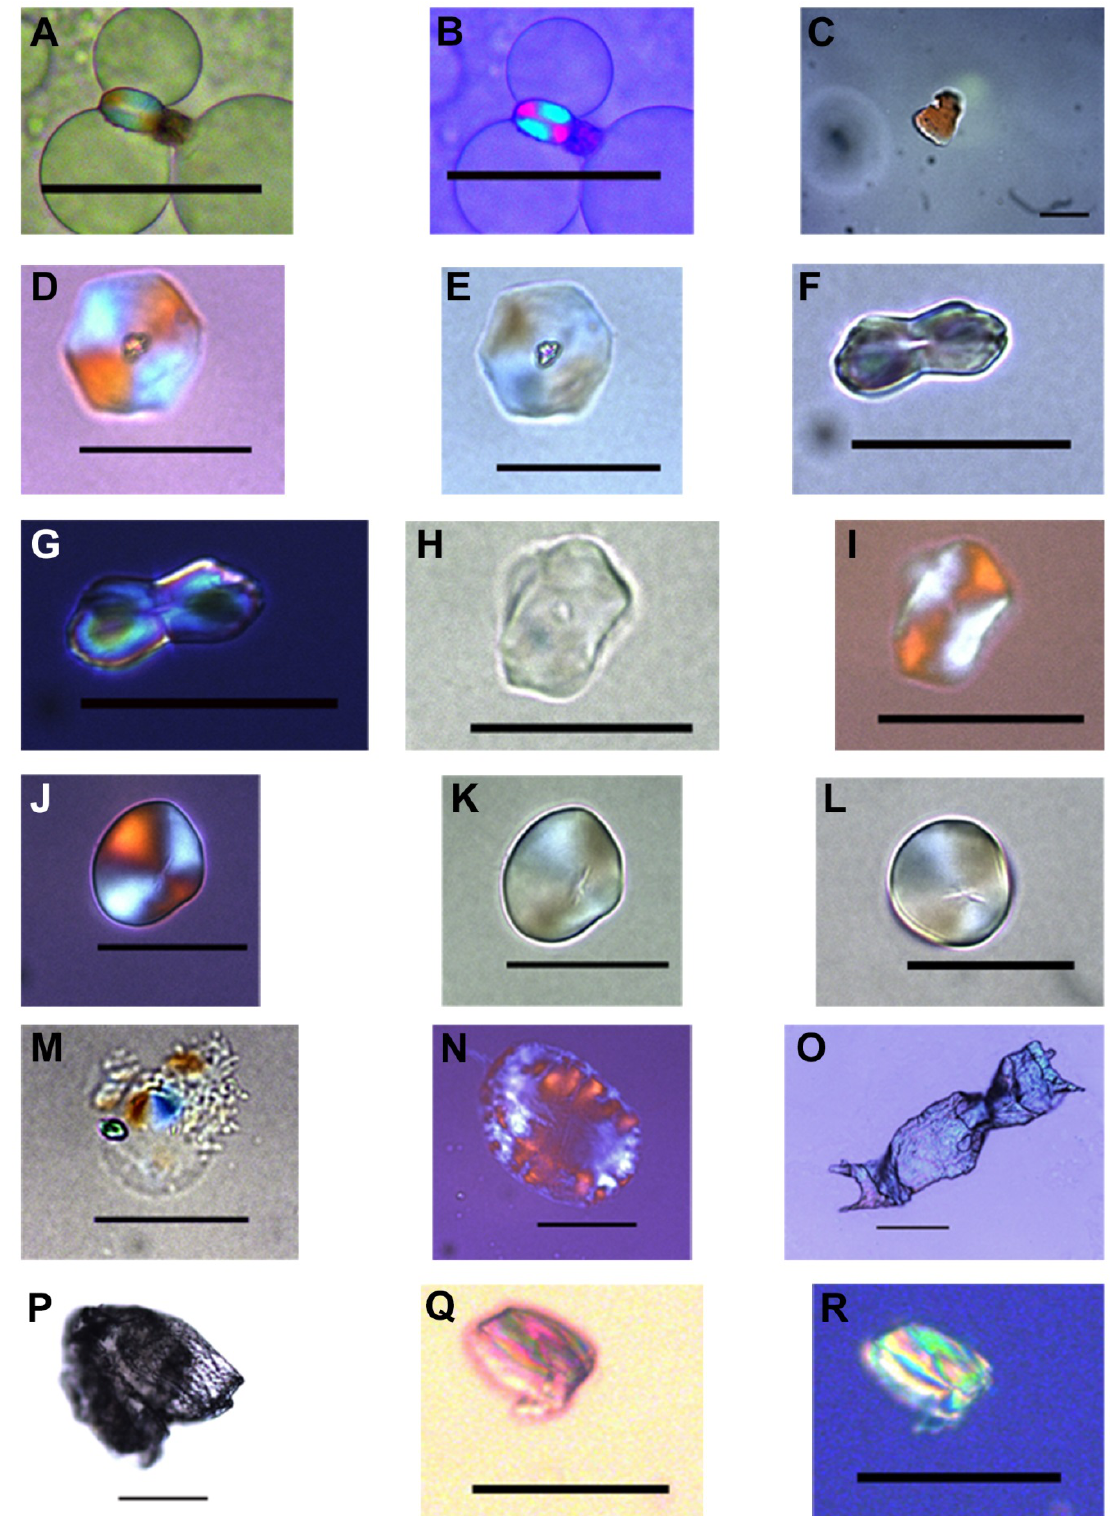
Figure 15. Starch grains and various elements recovered from sediment I (A, B and C) and II (D-R) at the distal part of the archaeological tool. AB: Starch grain 1 recovered from sediment I. C: Non-identified element 1 recovered from sediment I. D-L: Starch grains recovered from sediment II; D-E: grain 1; F-G: grains 2 and 3; H- I: grain 4; J-L grain 5. M, N, Q, R: Non-identified elements recovered from sediment II; M: element 1, N: element 2; R: element 3. O-P: Vessel elements recovered from sediment II. Photos taken under bright field (A, E, F, H, K, L, O, P, Q) and polarized light (B, C, D, G, I, J, M, N). Scale bar: A, B, Q, R, 50 µm; C- N: 20 µm; O-P, 100 µm. Photos by Rodrigo Angeles